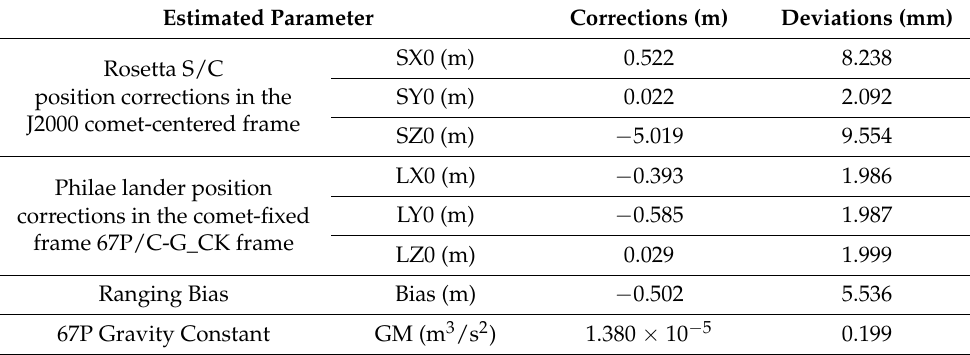
Table 7. Parameters corrections and associated formal errors for the parameters, with respect to the least-squares fit corresponding to Equations (1)–(3) and the initial values and parameters given in Table